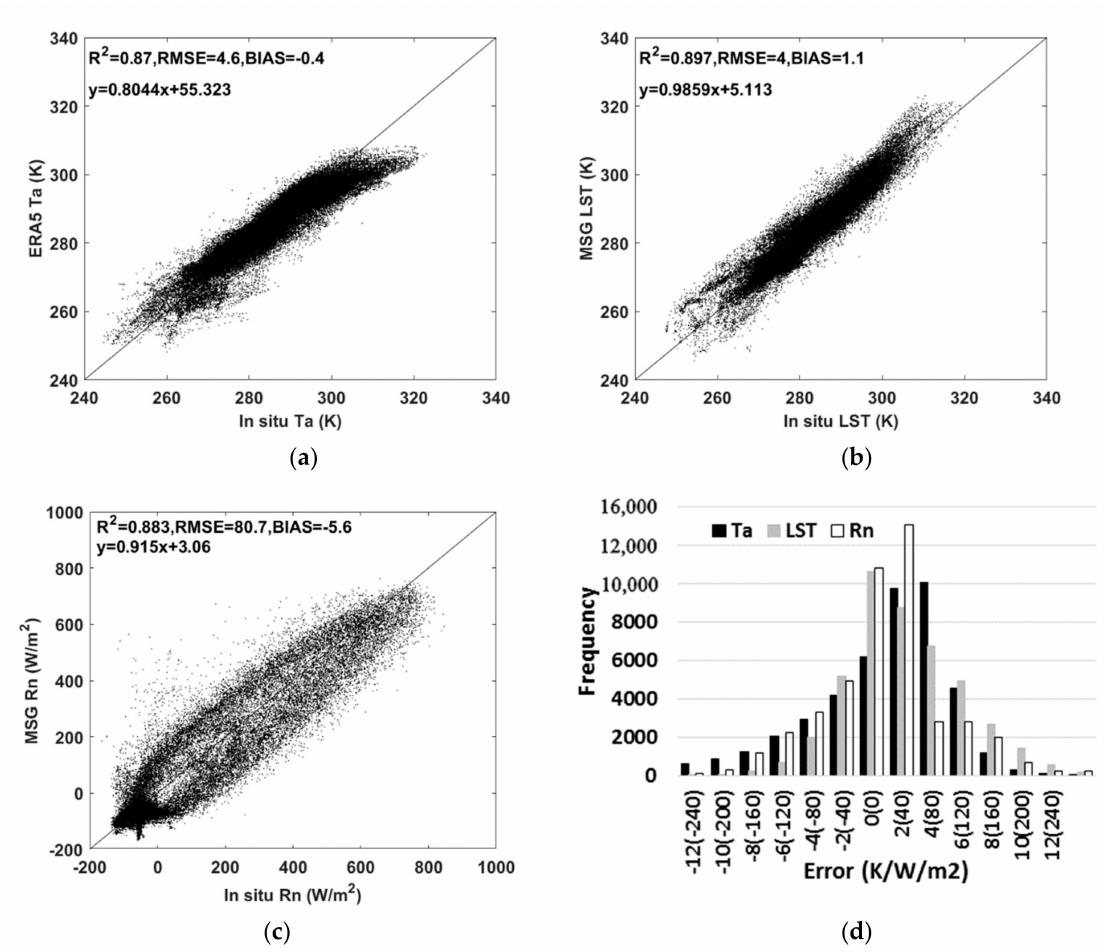
Figure 6. Comparisons of: ( a ) ERA5 T a ; ( b ) MSG land surface temperature (MLST) product; and ( c ) MSG-calculated R n at 30 min intervals with in situ measurements from the FLUXNET2015 dataset; and ( d ) their error frequency histograms.